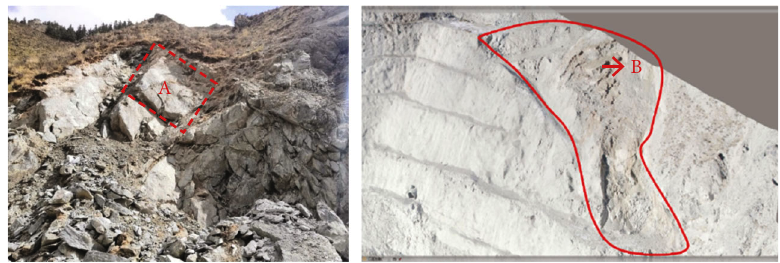
Figure 4: Sliding-slip perilous rock on both banks of the dam site.